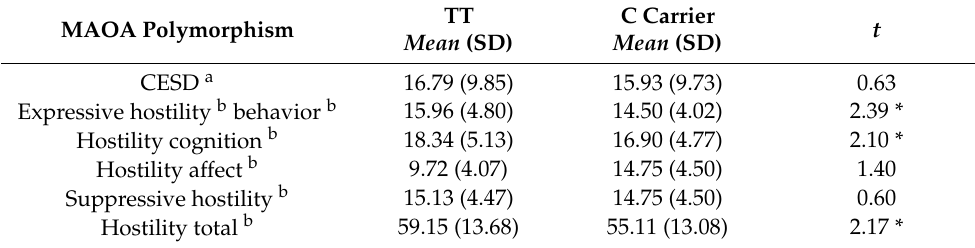
Table 2. Associations among depression and hostility scores and the MAOA EcoRV